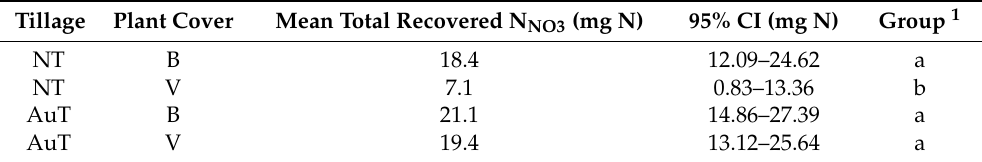
Table 1. Nitrogen as NO 3 − (N NO3 ) leached from intact topsoil cores subjected to 200 mm of simulated rain. Mean values and 95% confidence intervals (CI) were obtained from linear mixed effects models with tillage and plant cover as main effects and experimental block as random effect. Tillage Plant